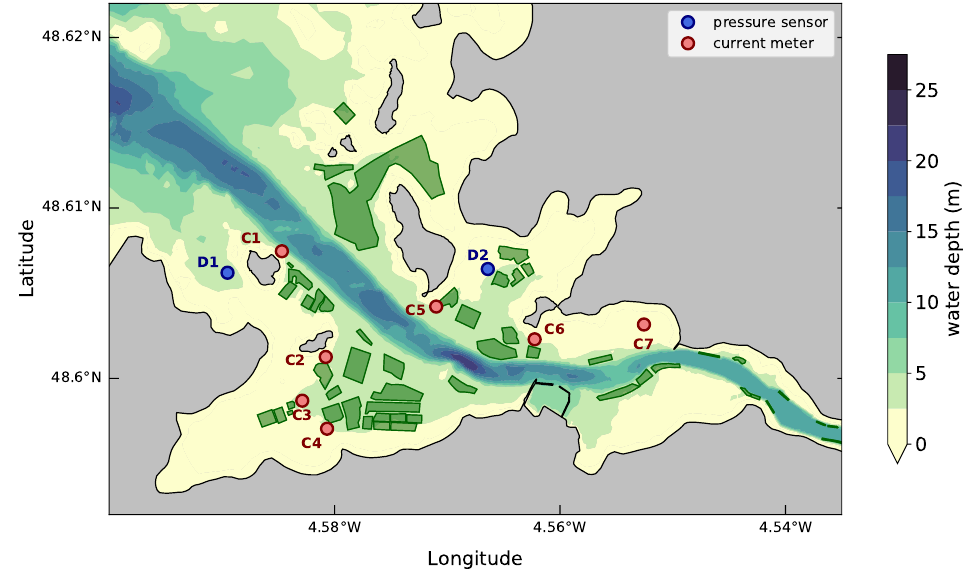
Figure 2. Bathymetry of the Aber Wrac’h estuary located in western Brittany (France), with the locations of measurement points (pressure sensors and current meters). Green areas delimit the extents of oyster farming elevated structures within the